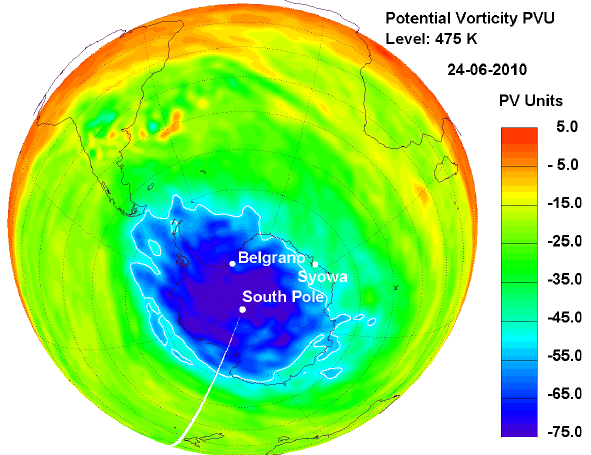
Fig. 1. Stable polar vortex over Antarctica represented by the po- tential vorticity (PV) at 475K-level on 24 June 2010. The white line indicates the edge of the polar vortex. Also shown are the lo- cation of Belgrano II station (Argentina, 77.9 ◦ S 34.6 ◦ W) together with Syowa (Japan, 69.0 ◦ S 39.5 ◦ E), which is outside the polar vor- tex edge, and South Pole/Amundsen-Scott (USA, 89.98 ◦ S 24.8 ◦ E)